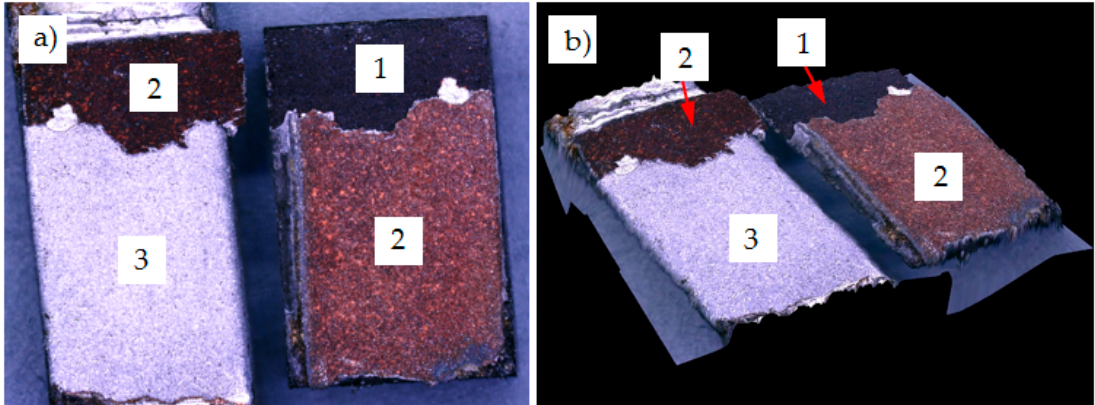
Figure 12. Adhesive fracture in solder joint under shear test (sample no. 4) ( a ) and 3D view of fracture ( b ); 1—graphite composite; 2—Cu coating; 3—6060 aluminum alloy.